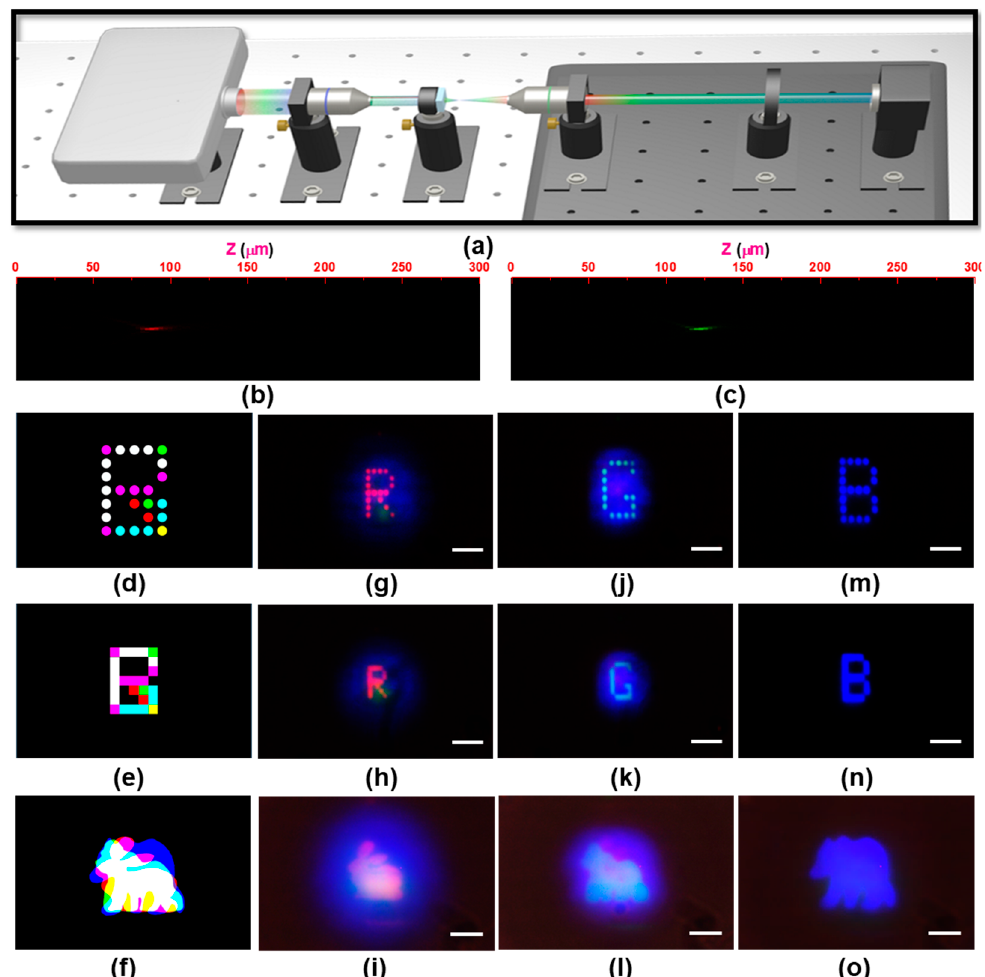
Figure 3. ( a ) Schematic for the setup of the image decryption by the metalens; the cross-sectional intensity distribution using 633 and 532 nm laser as the light incidence, respectively, shown in ( b , c ); ( d – f ) the encrypted images produced by the projector; ( g – i ) the decrypted images with the dotted and solid red capital letter R in ( g , h ), respectively, together with a red rabbit in ( i ); ( j – l ) the decrypted images with the dotted and solid green capital letter G in ( j , k ), respectively, together with a green gorilla in ( l ); and ( m – o ) the decrypted images with the dotted and solid blue capital letter B in ( m , n ), respectively, together with a blue bear in ( o ); Scale bar: 10 µ m in ( g – o ).